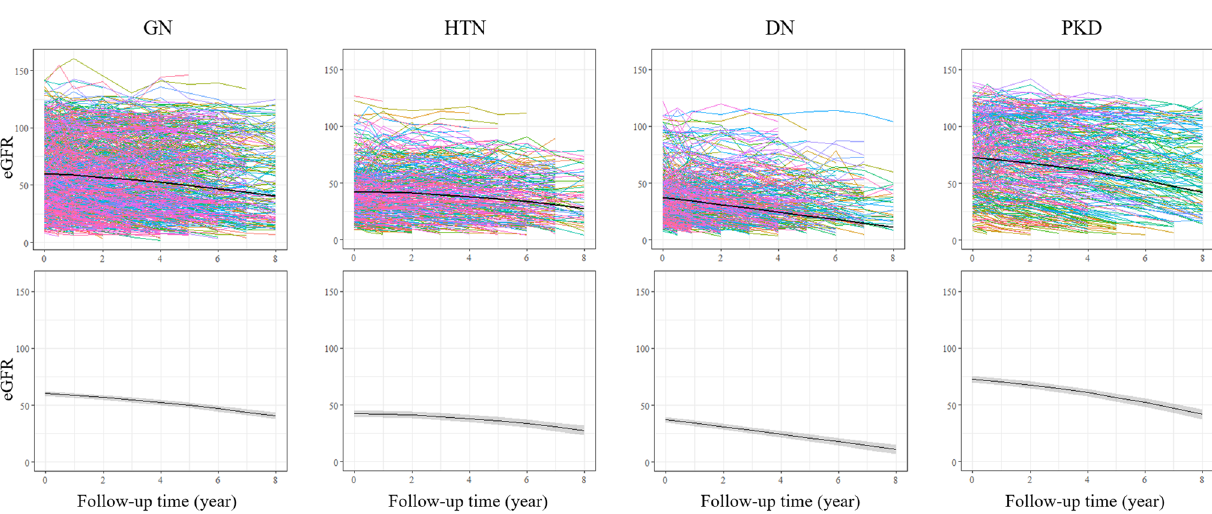
Figure 3. Spaghetti plots (up) and trajectory of eGFR changes (down) during follow-up in each CKD etiology group. Each colors of spaghetti plot indicates trajectory of each patients (up) and the black line represents the mean estimated eGFR trajectory of each groups (with 95% CI represented by the gray shaded area). The trajectory are classified into two types. DN showed a linear decline in eGFR but GN, HTN and PKD showed a convex decline with acceleration of the annual eGFR decline in advanced CKD stages. DN, diabetic nephropathy; eGFR, estimated glomerular filtration rate; GN, glomerulonephritis; HTN, hypertensive nephropathy; PKD, polycystic kidney